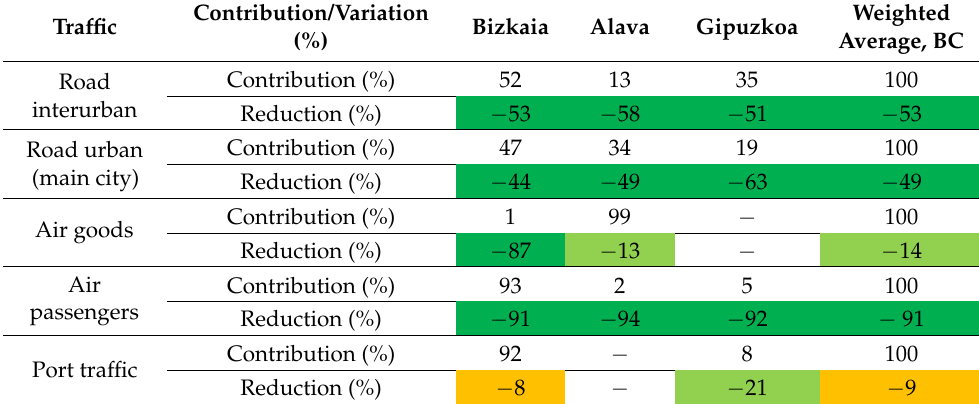
Table 4. Contribution (%) and variation (%) of mobility in 2020 compared to 2019 in the three provinces of the Basque Country during the period studied (w0-w14) in different areas: interurban and urban traffic, air goods, passengers, and port traffic. Large reduction (from − 100.0% to − 25.0%), reduction (from − 24.9% to − 10.0%), small reduction (from − 9.9% to − 0%)